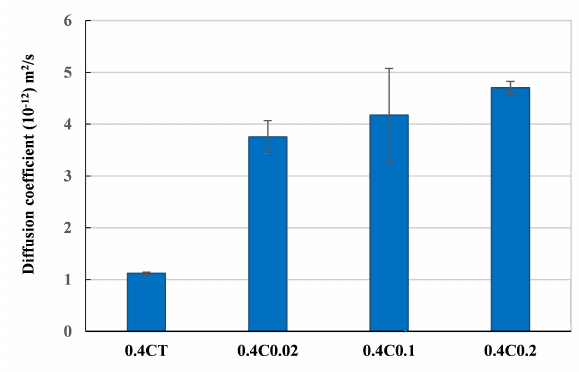
Figure 6: Chloride migration coeflcient of the mortar with MWCNTs